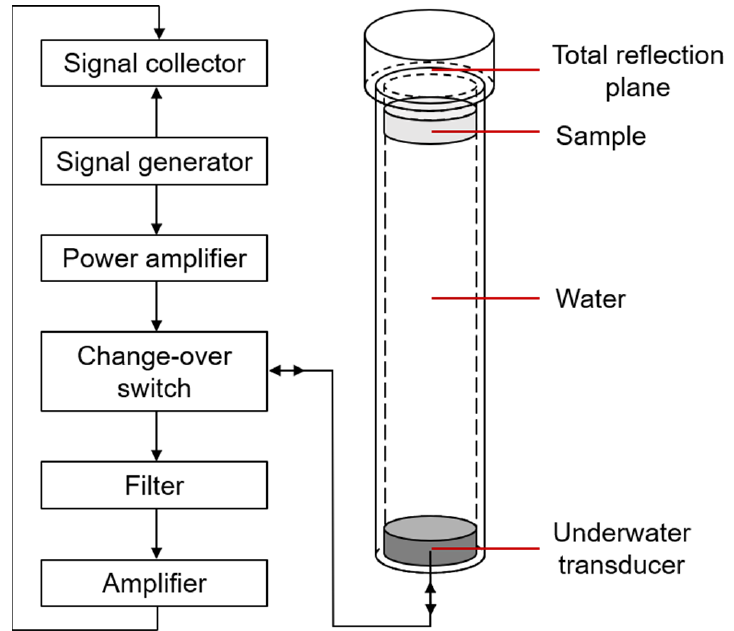
Figure 12. Schematic of the acoustic pulse tube device.